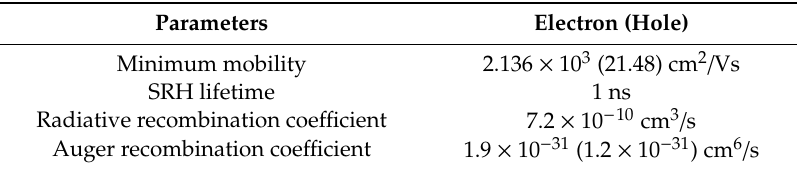
Table 1. Key simulation parameters.